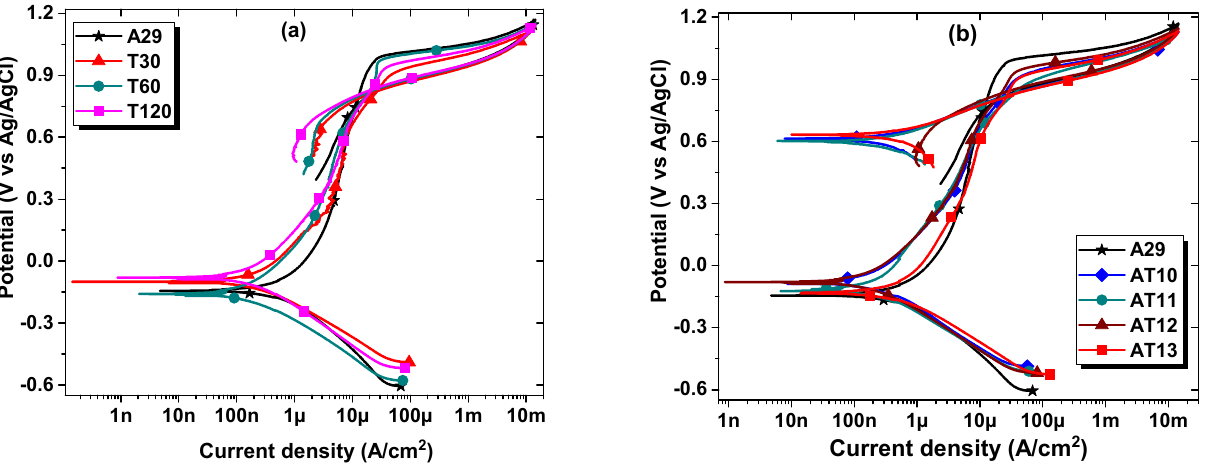
Figure 9. CPDP curves showing the effect ( a ) solutionizing duration and ( b ) solutionizing temperature on the corrosion behavior of UN08029 after 1 h immersion in 3.5% NaCl aerated solution Table 5. The Tafel extrapolated data and pitting parameters obtained from the CPDP measurement for the samples heat ‐ treated at different solutionizing durations.